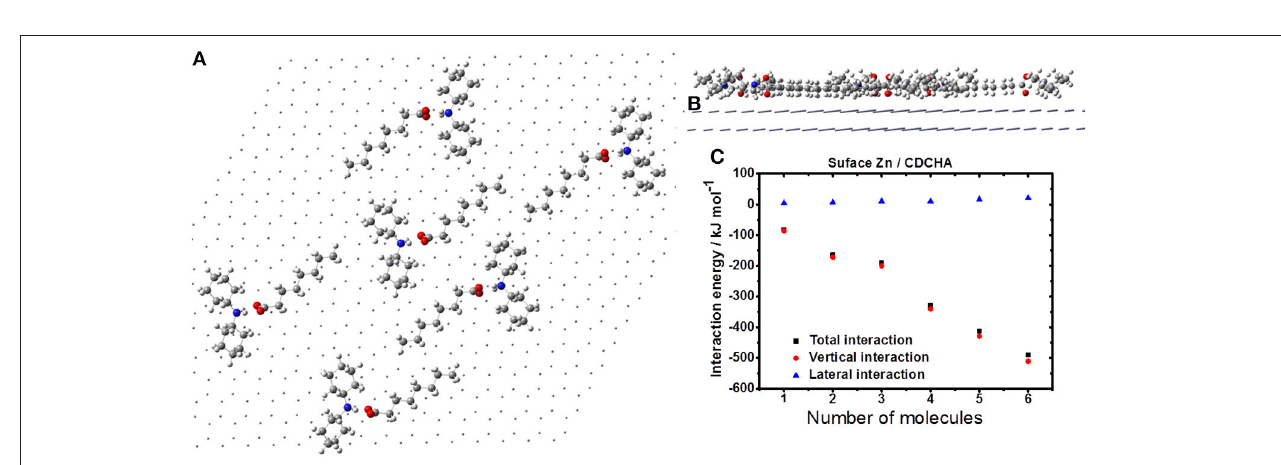
FIGURE 7 | Formation of CDCHA film on the zinc surface: horizontal (A) and vertical (B) views; (C) interaction energy.